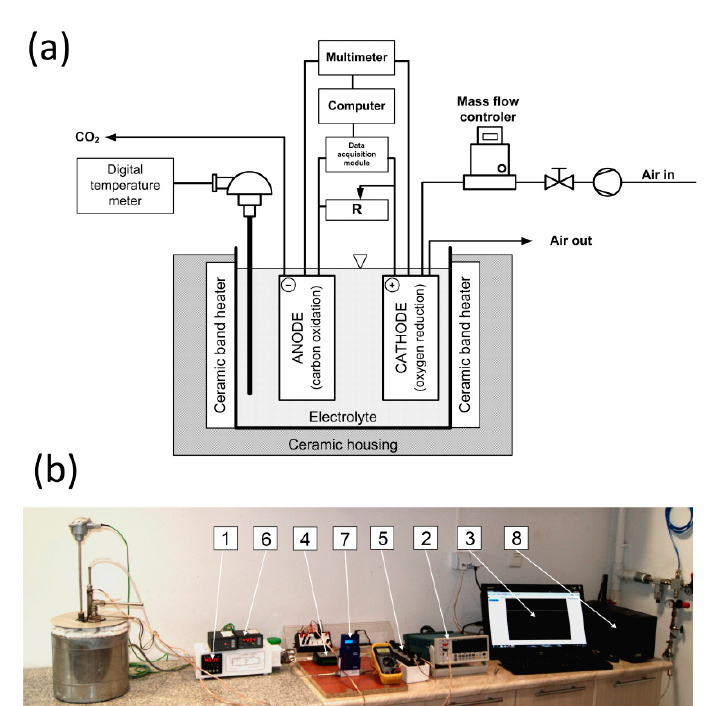
Figure 11. Schematic diagram ( a ) and depiction ( b ) of the MH-DCFC test setup. 1—electronic temperature controller (thermostat), 2—digital multimeter, 3—computer PC, 4—data acquisition